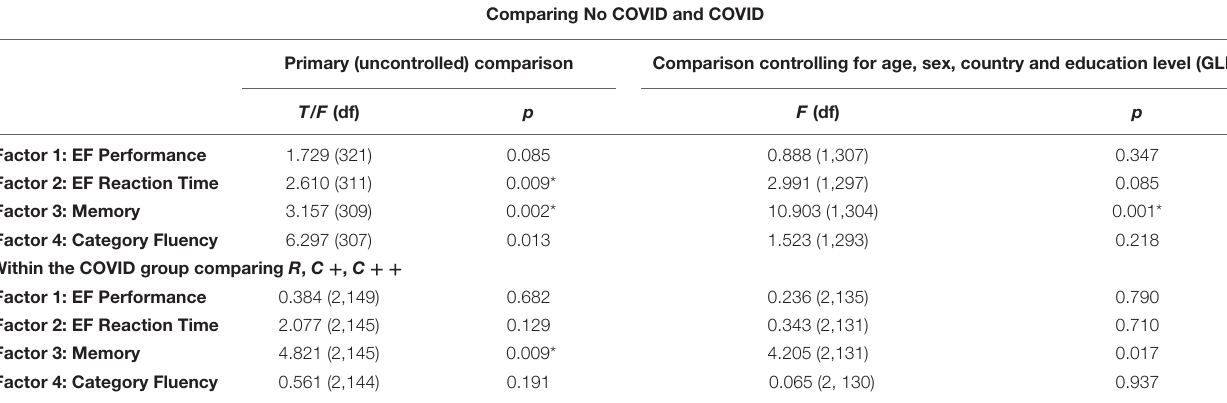
TABLE 1 | Cognitive performance factors across COVID and No COVID groups (top) and symptom severity levels (bottom). Comparing No COVID and COVID Primary (uncontrolled) comparison Comparison controlling for age, sex, country and education level (GLM)